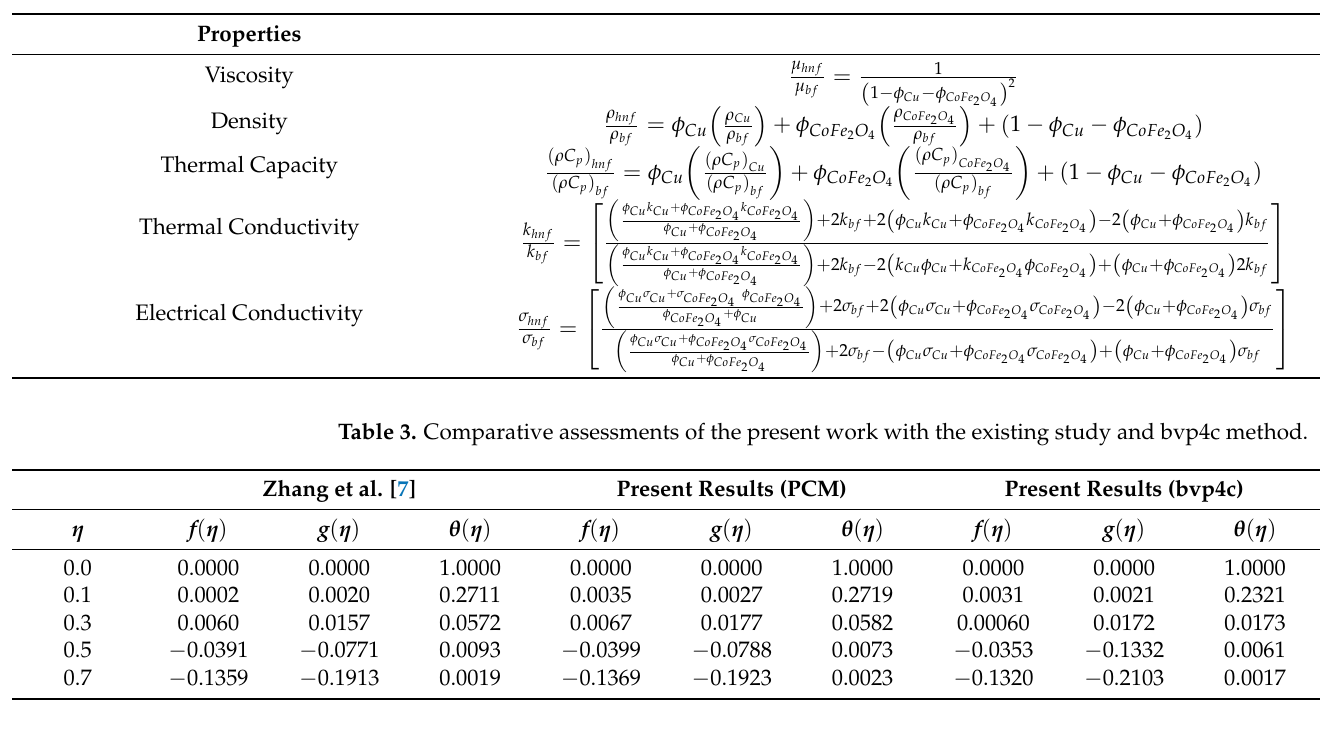
Table 2. The thermal characteristics of the hybrid nanoliquid ( φ 1 = φ Cu , φ 2 = φ CoFe